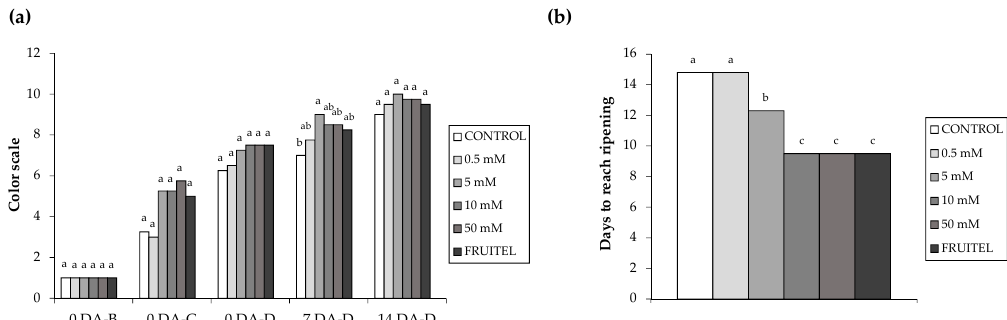
Figure 2. Color change of Vitis vinifera L. cv Alicante Bouschet berries of non-treated (CONTROL) plants, HB weekly-treated plants at different concentrations (0.5, 5, 10, 50 mM) and plants treated with the ripening inducer FRUITEL. ( a ) Evolution of color of non-treated, HB-treated and FRUITEL- treated plants. ( b ) Number of days until CONTROL, HB and FRUITEL treated plants reached ripening. An ANOVA test was performed, and different letters indicate statistical significances with a p -value < 0.05.